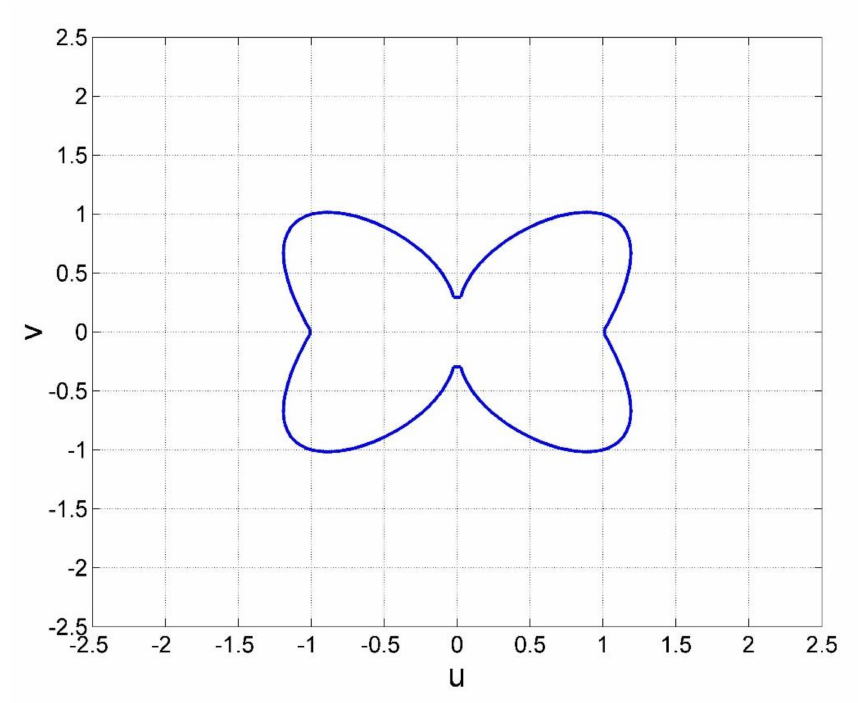
Figure 1. The butterfly-like curve S of balance points of the system (4) given by the following (cid:12) (cid:12) (cid:12)(cid:12) (cid:12) equations: u 4 + v 4 − (cid:12) u (cid:12) v (cid:12) − u 2 = 0, w = 0 (for all values of a , b , c